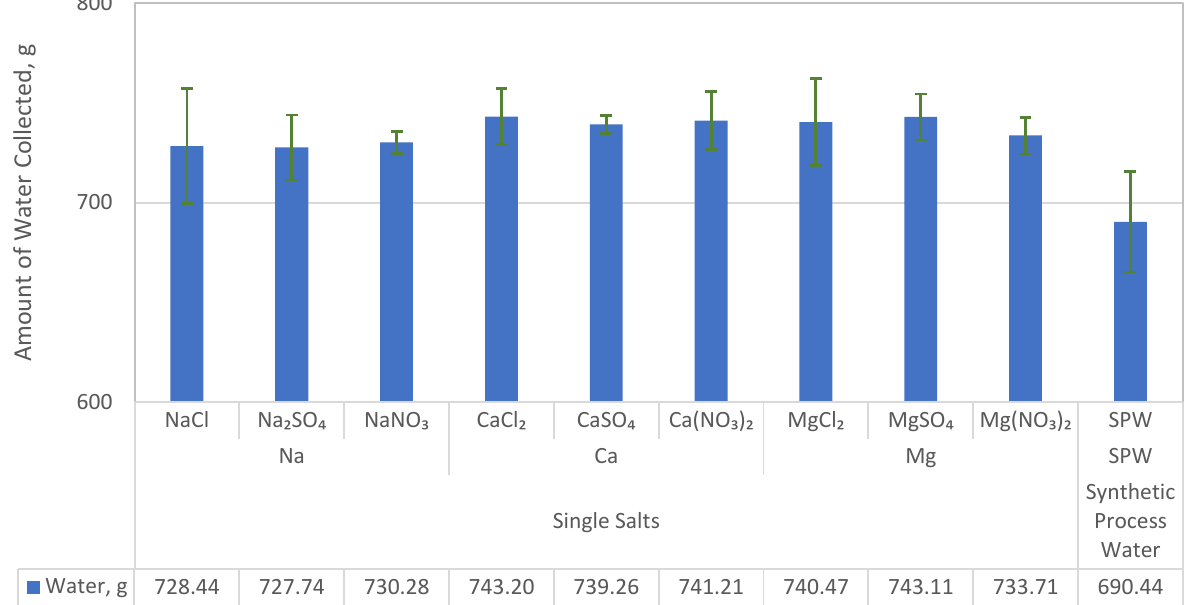
Figure 4. Amounts of water reporting to the concentrates for all single salts and SPW in a two-phase system.